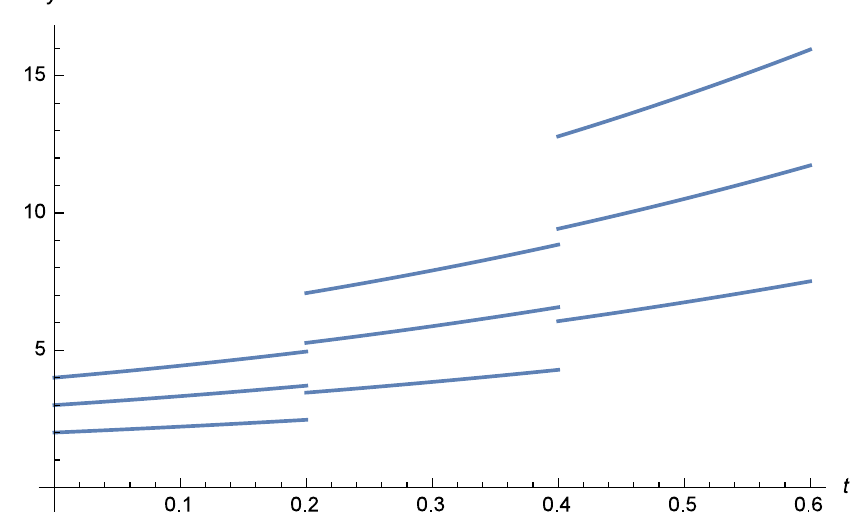
Figure 1. The solution of the fuzzy differential-difference Equations (21) and (22) for α =